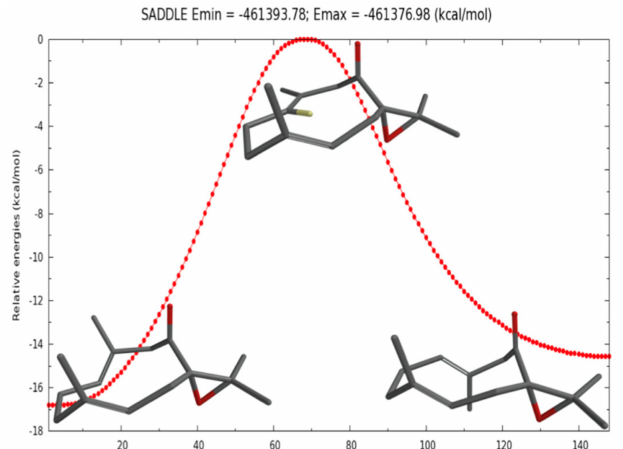
Figure 4. Barrier of exchange between conformations UU and UD and the transition state between both of them.